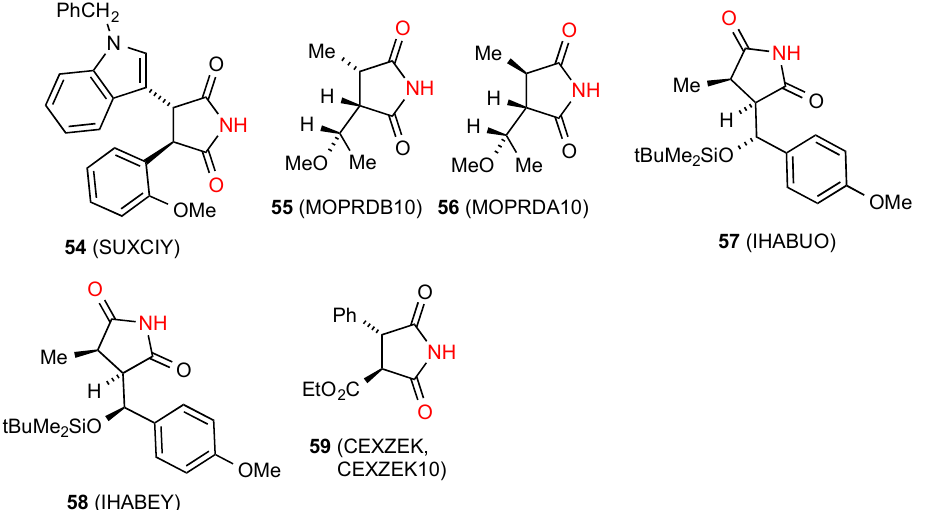
Figure 19. 3,3-Disubstituted succinimides with patterns E and F.